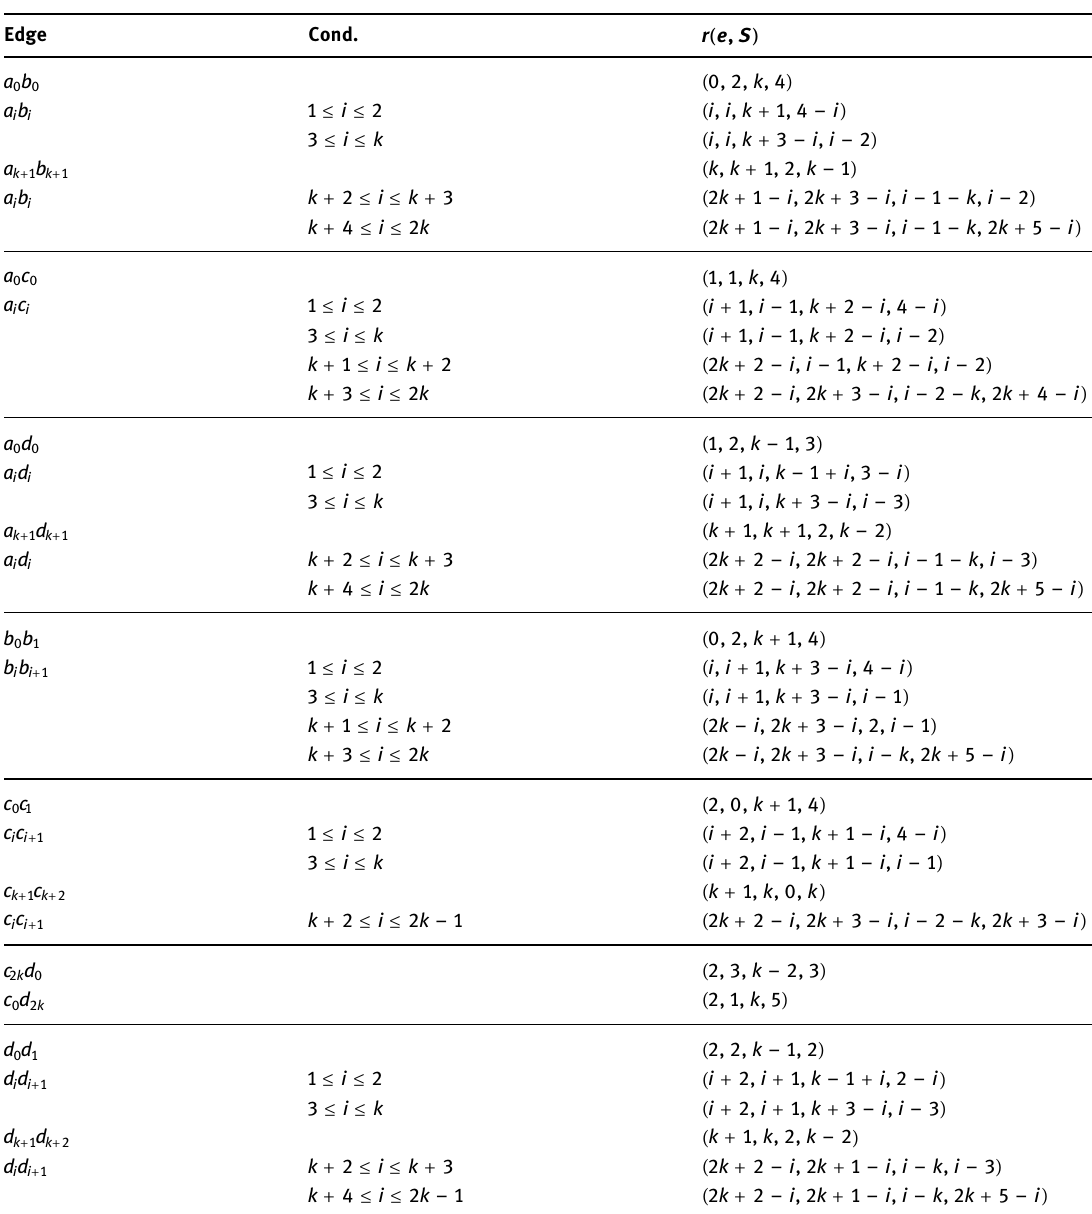
Table 2: Metric coordinates of edges of J k 2 1 + Edge